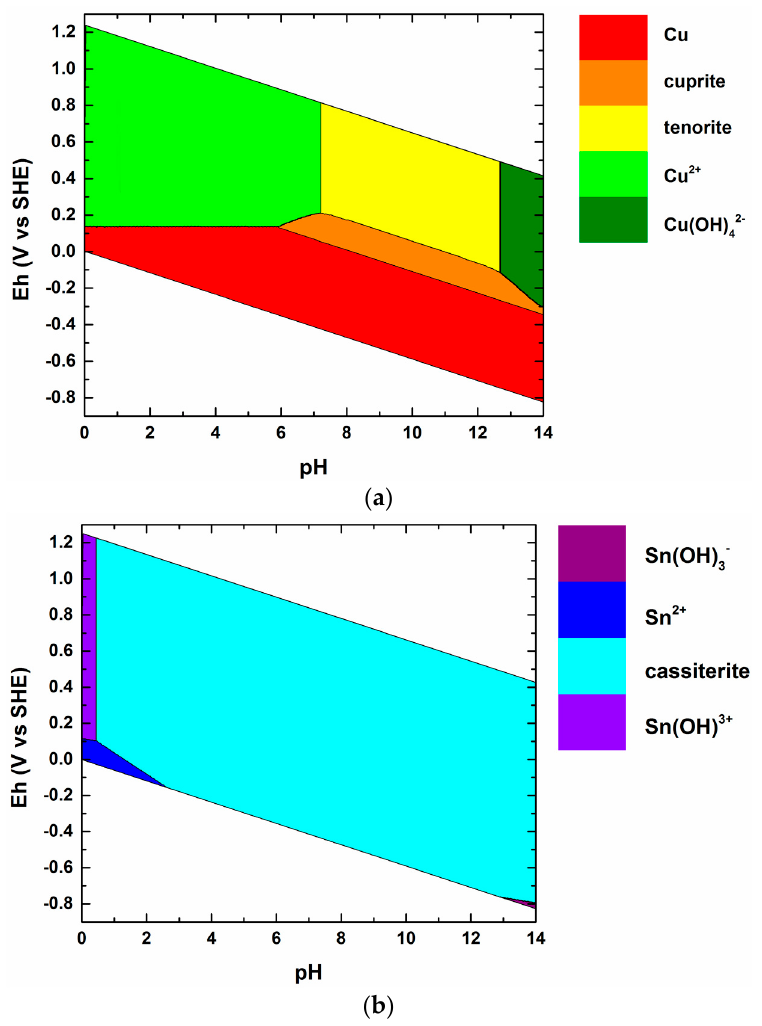
Figure 2. Eh-pH diagrams of: ( a ) the Cu–O–H system, calculated assuming [Cu] = 10 − 6 mol/kgw; ( b ) the Sn–O–H system, calculated assuming [Sn] = 10 − 8 mol/kgw.